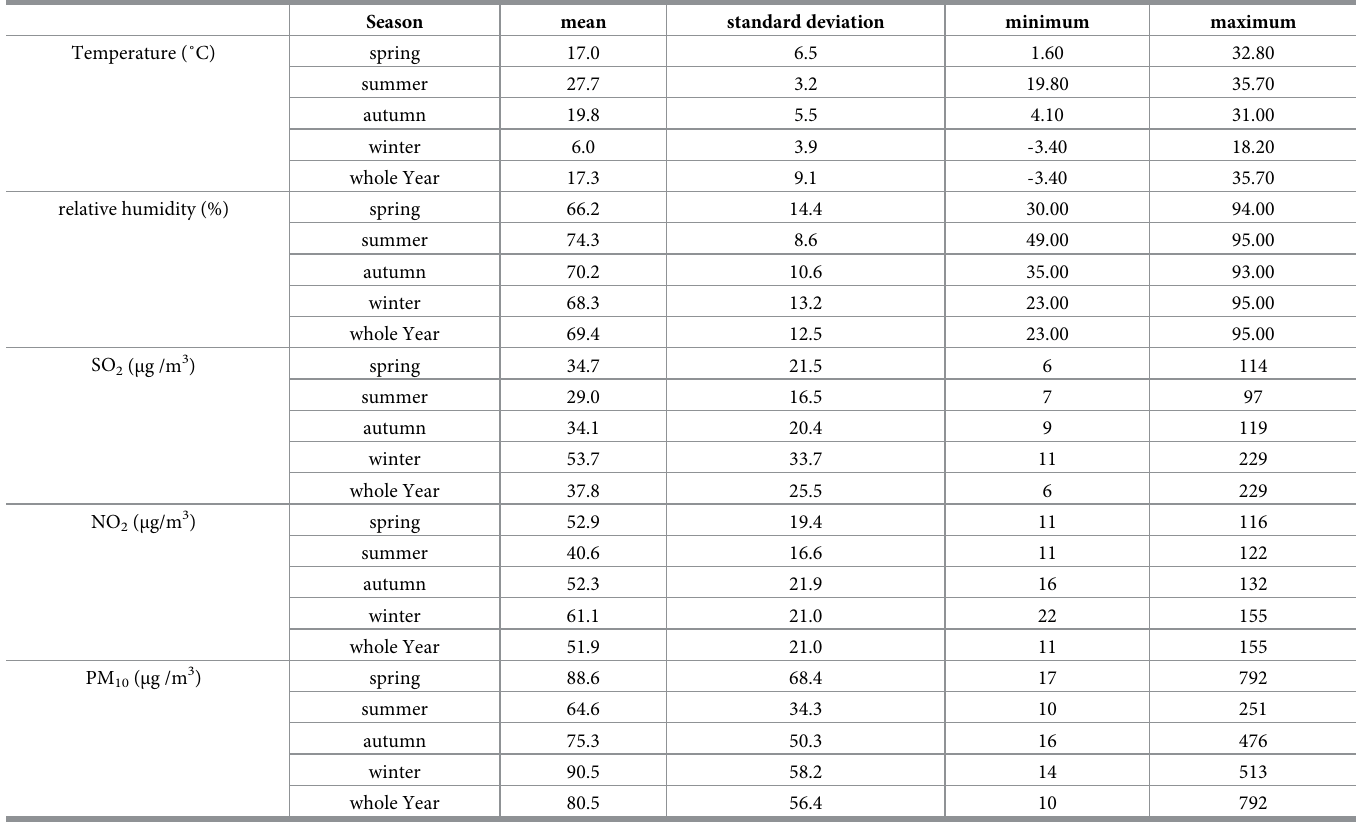
Table 2. The description of ambient temperature, relative humidity, air pollutants during 2007–2011 � . Season mean standard deviation